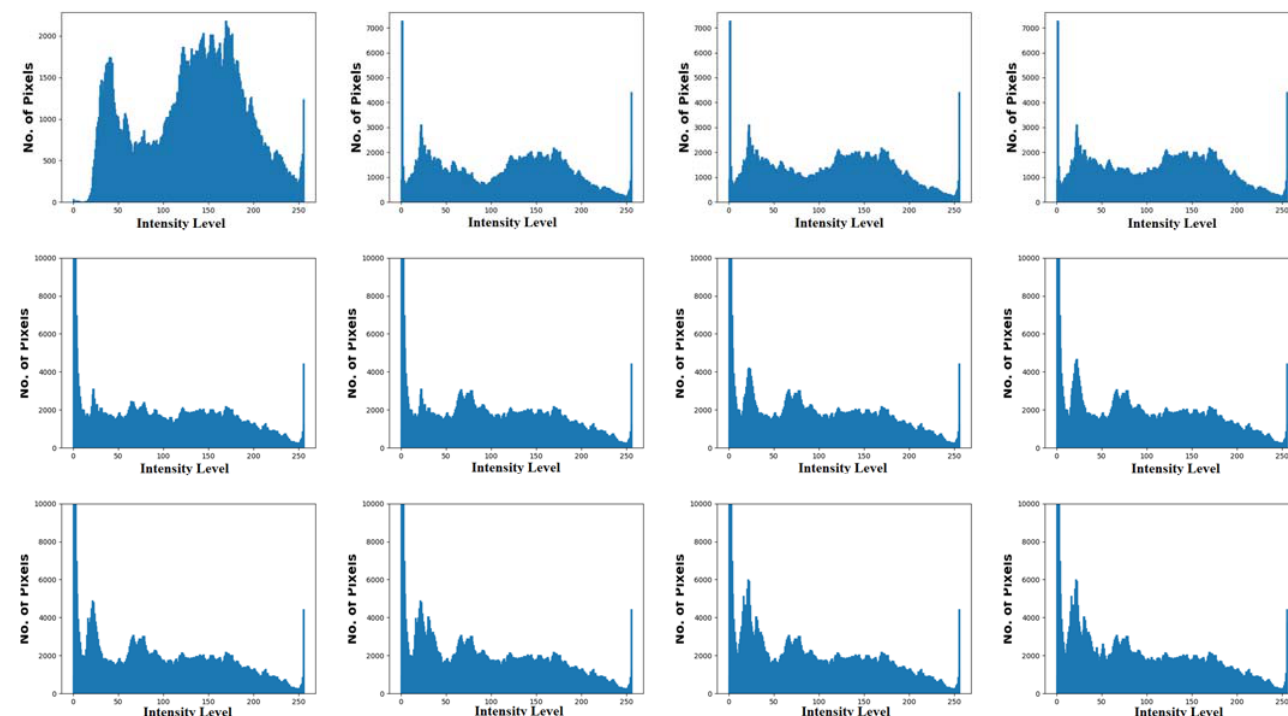
Figure 4. Histogram of the images.